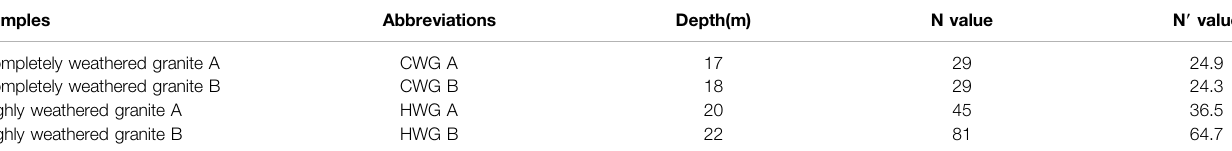
TABLE 1 | Parameters for weathered granite samples.